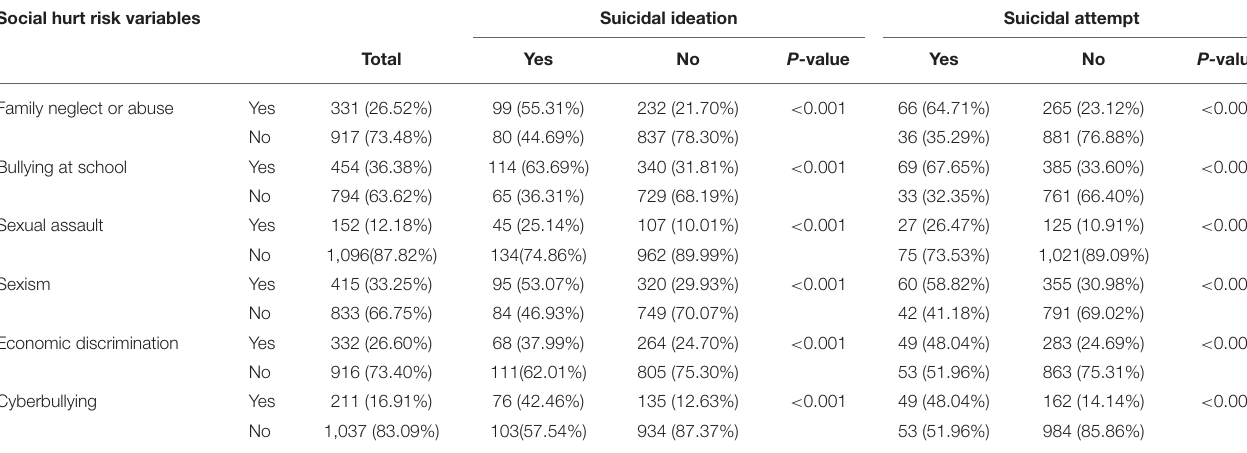
TABLE 2 | The different trauma among adolescents experiencing suicidal ideation and those with a history of the suicide attempt. Social hurt risk